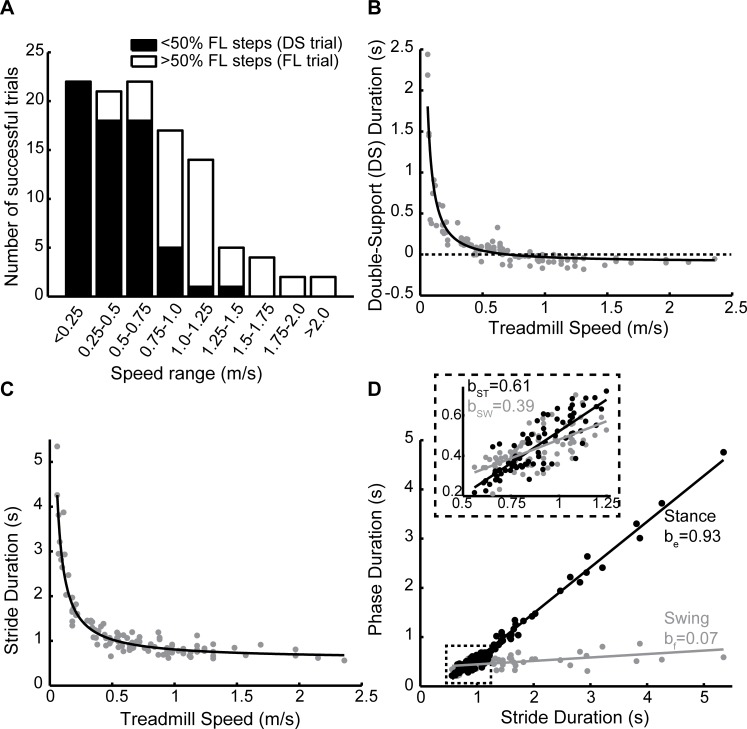
Adaptation to treadmill speed: stride cycle modifications.(A) The number of trials that were analyzed at each treadmill speed is shown by the height of each bar. Trials in which the majority of strides had a period of double support are shown in black; trials with a majority of flight strides are in white. (B) Average double support duration for each successful trial shown in (A). Negative values indicate flight. Data were fit with a second order power function (axb + c). (C) Average stride duration for each successful trial; data were fit with a second order power function, as described previously [11]. (D) Average durations of stance (black) and swing (grey) change linearly with stride duration–the slope (b) of each line is shown beside the plots. Inserted plot shows data from the highlighted region (stride duration = 0.55–1.25s; lines were re-fit to these data and recalculated slopes are shown in insert).